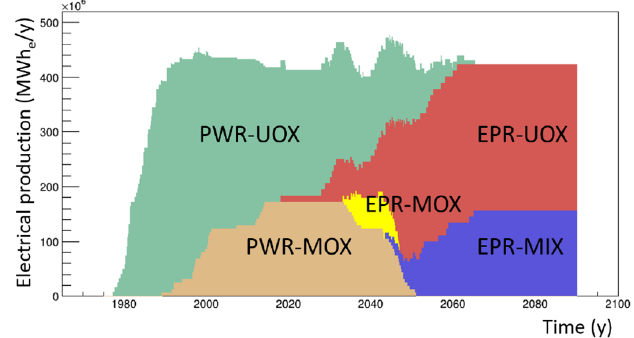
Fig. 6. Representation of the reactor